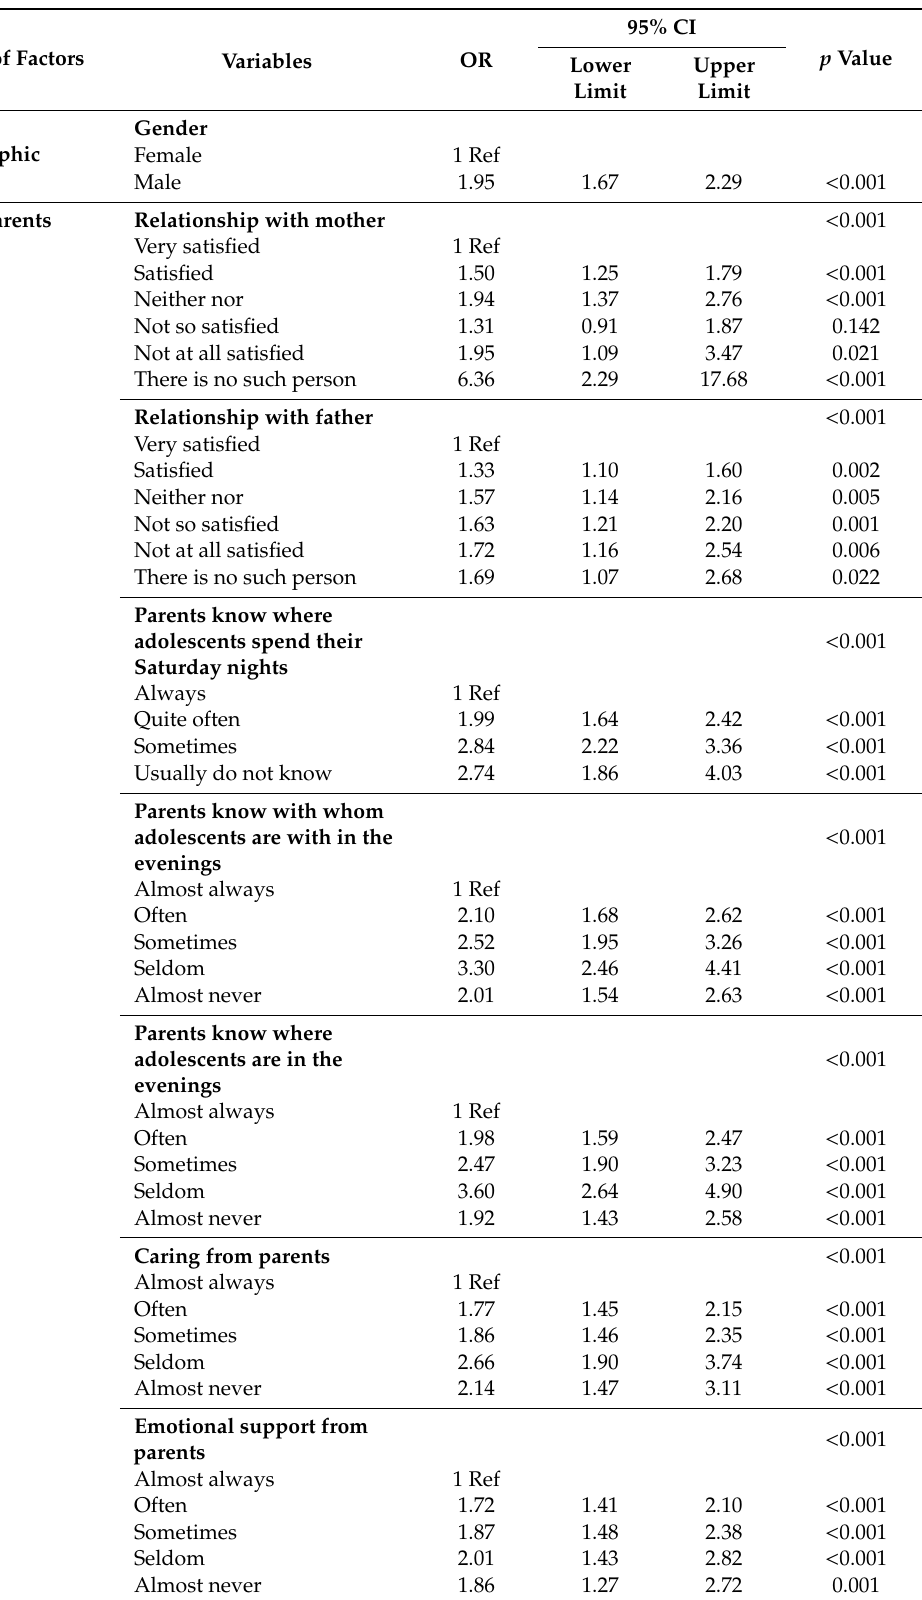
Table 1. Factors associated with physical fight experienced by Romanian students during the last 12 months determined by univariate analysis for the 2011 survey.